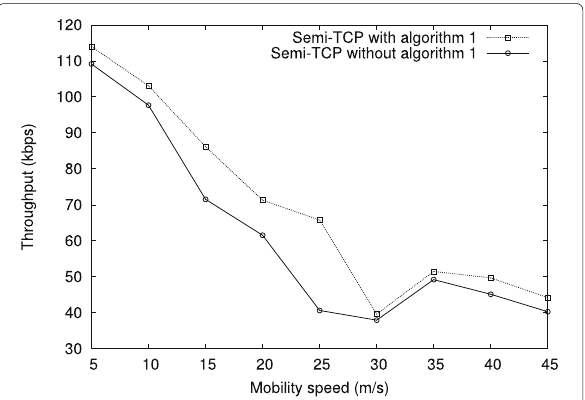
Fig. 11 End-to-end throughput in the random topology chain topology is the same as Fig. 1. In the mobile ran- dom topology, 48 mobile nodes, following the random waypoint mobility model are deployed in an area of 1500 × 3000 m 2 in the mobile random topology.